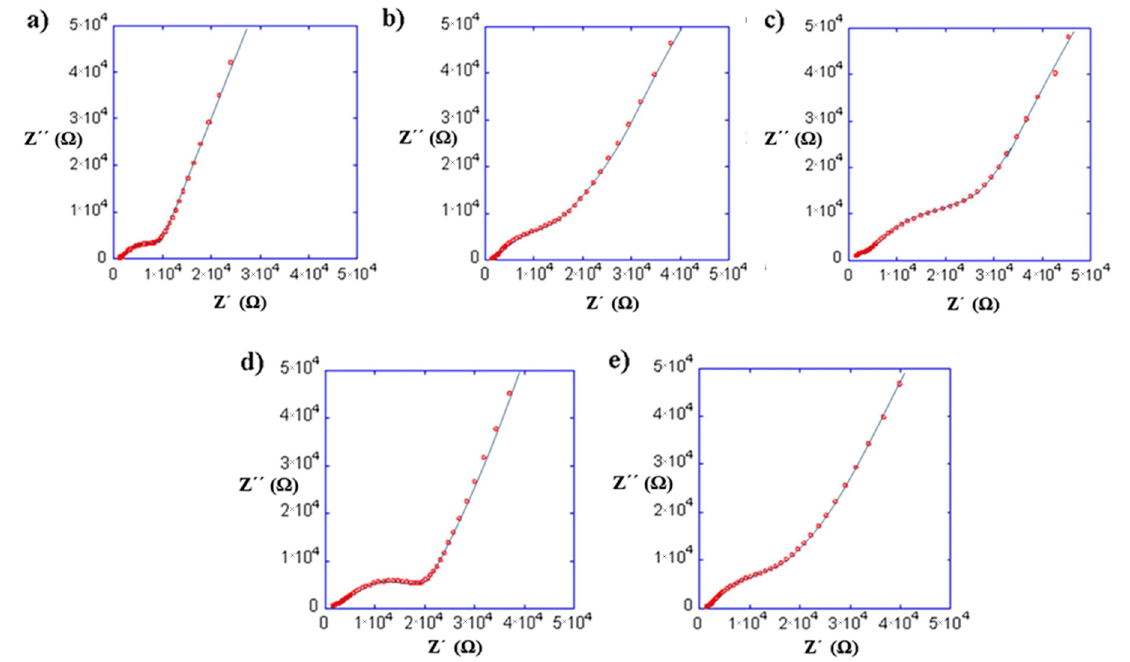
Figure 9. Impedance spectra at 25 °C of the composites with 10% of ( a ) PEO, ( b ) PEG, ( c ) PAN and PEO copolymers: ( d ) PEO/EP and ( e ) PEO/EM/AGE. Table 3. The total conductivity for La 0.5 Li 0.5 TiO 3 and 10% polymer-composite samples obtained from bulk and grain boundary resistivities at room